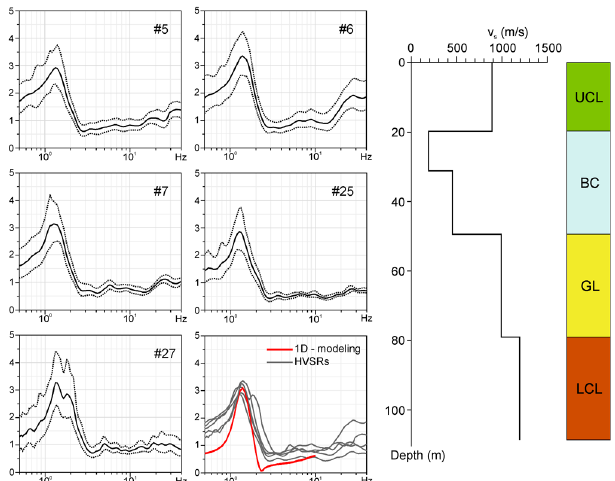
Fig. 5. HVSR results at recording sites located in the not fractured zone, stratigraphic sequence, shear wave velocity profile and com- parison of experimental spectral ratios with 1-D theoretical mod-